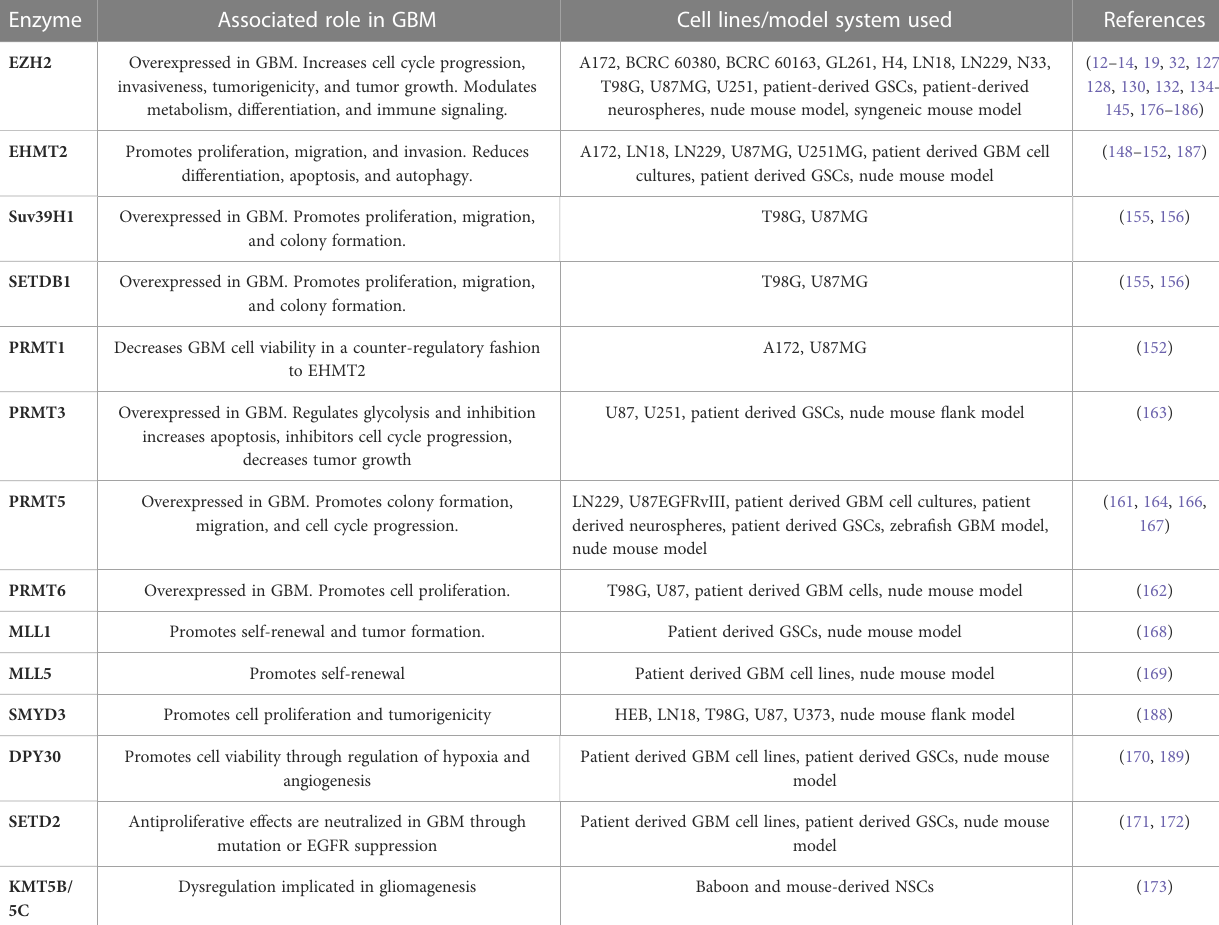
TABLE 4 The function of histone methyltransferases in GBM. Enzyme Associated role in GBM Cell lines/model system